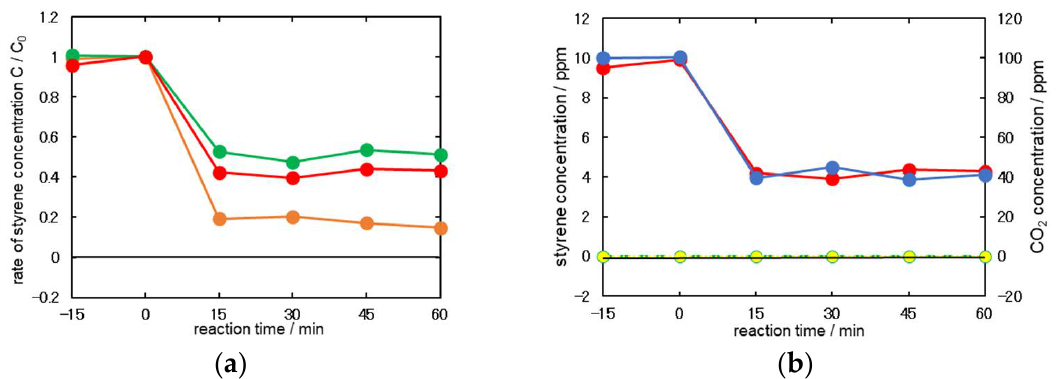
Figure 1. ( a ) Typical data set of styrene removal by reaction with each ozone concentration (green, red, and orange indicate 7 ppm, 12 ppm, and 22 ppm, respectively). ( b ) Typical data set of styrene removal (red, blue) and CO 2 generation (green, yellow) by reaction with ozone (red, green: with UV irradiation, blue, yellow: without UV irradiation).